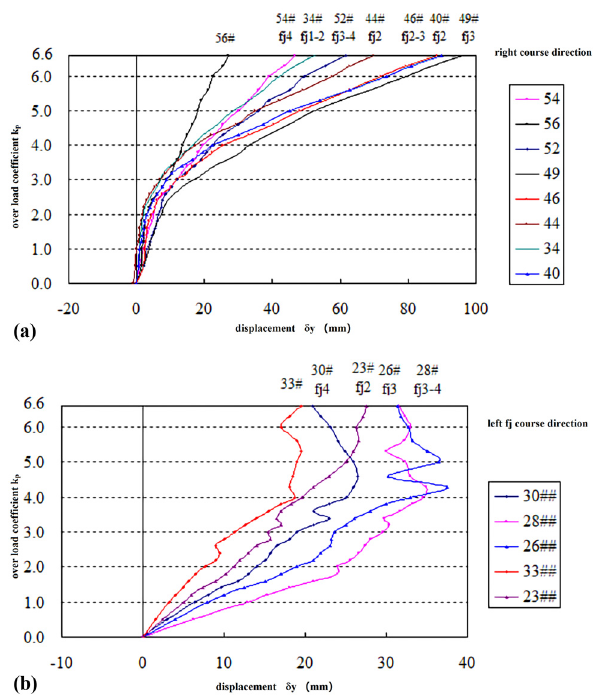
Figure 9: ( a ) The relative displacement δ y – K p curve of left bank A – A along river. ( b ) The relative displacement δ y – K p curve of right bank a – a along